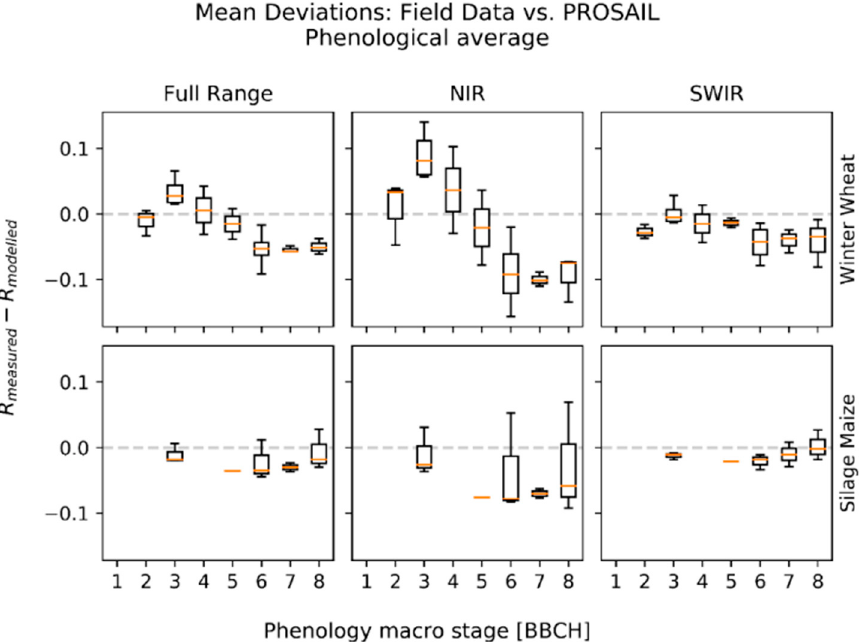
Figure 5. Mean deviations as the difference between field spectral measurements and PROSAIL model output, aggregated into BBCH growth stages. Positive values indicate an underestimation, negative values an overestimation of the model. Seasonal patterns are more distinct for winter wheat than for silage maize with emphasis on deviations in the NIR region.